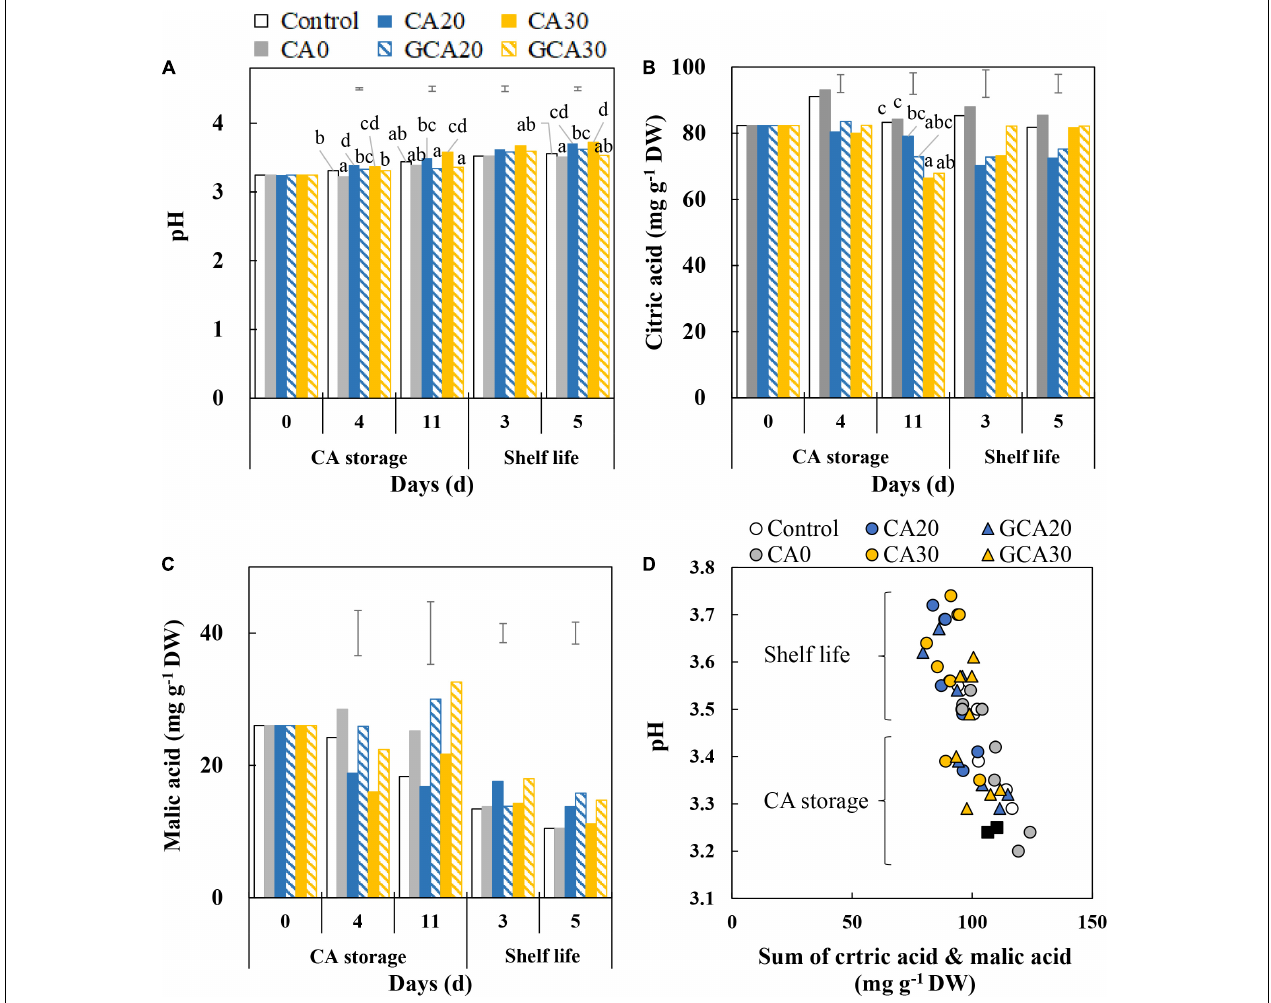
FIGURE 4 | pH and main organic acids of “Arabella” strawberry fruit during CA storage and shelf life. (A) pH, (B) citric acid, and (C) malic acid during CA storage at 5 ◦ C and ∼ 100% relative humidity and subsequent shelf life at 12 ◦ C and ∼ 95% relative humidity in ambient atmosphere. Data represent means of 2 blocks ( n = 2; each block being a pooled sample of 20 replicated fruit). The error bars represent the standard error of means. Different letters denote significant differences according to Fisher’s protected LSD test ( α = 0.05). (D) Correlation between pH and sum of citric and malic acids of CA treatments during CA storage and subsequent shelf life. The closed black squares represent data of day 0. Data represent individual blocks. As a control condition, 21 kPa O 2 and 0 kPa CO 2 were